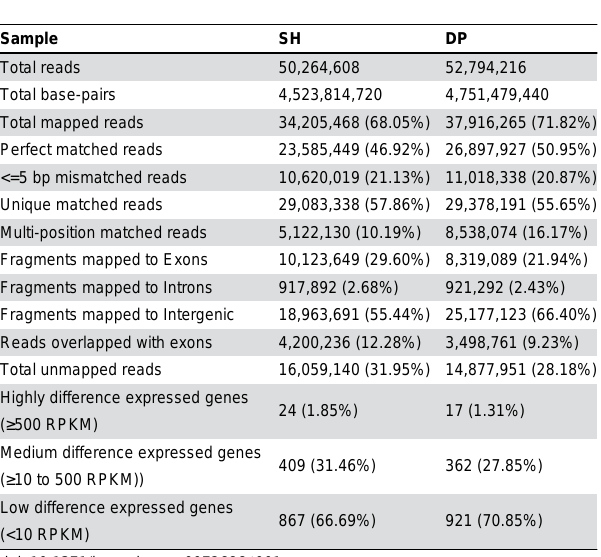
Table 1. A summary of the sequencing reads alignment to the Ovis aries genome.